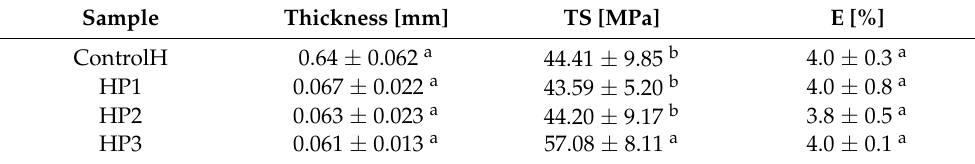
Table 3. Mechanical properties of